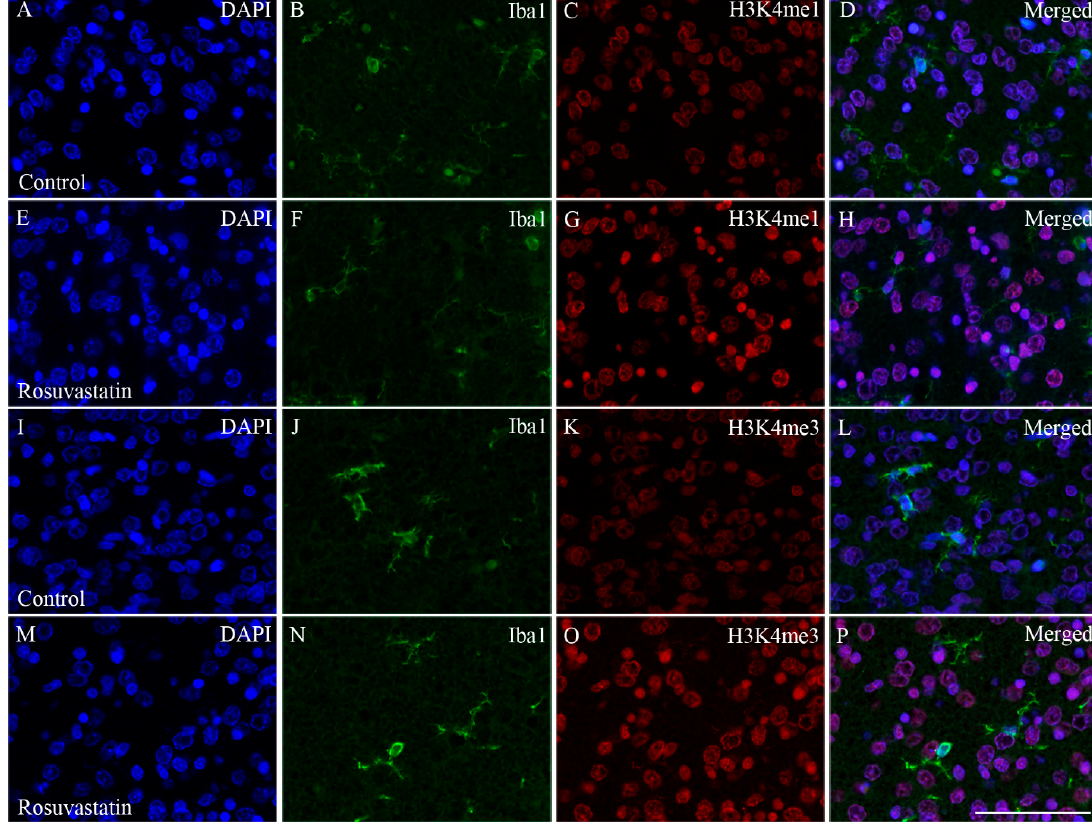
Figure 10. Laser confocal microscopy images of H3K4me1 and H3K4me3 immunoreactivities in microglial nuclei. New- born brain sections from the control ( A – D ) and RST-treated rats ( E – H ) were immunostained for Iba1 (green), and H3K4me1 or H3K4me3 (red), then visualized by confocal microscopy. DAPI-labeled cell nuclei are blue. Note in the merged pictures the very few microglia that colocalize with the histone methylation marks. Scale bar: 20 µm.